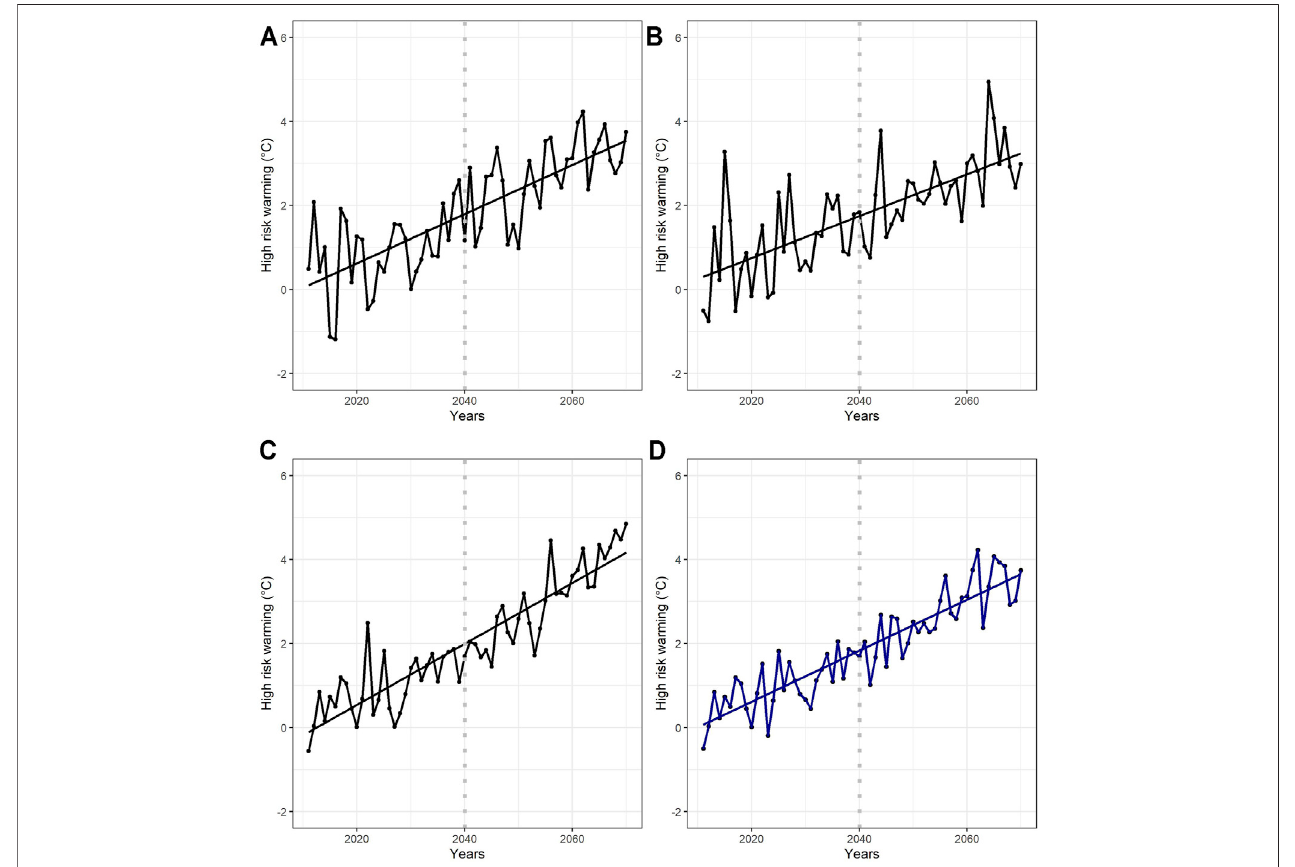
FIGURE 5 | HRW of temperature gauges in Ecuador from CSIRO (A) , GISS (B) , and IPSL (C) . Figure 5D is the ensemble that explains the median from three WGCMs. Values of the HRW axis are between − 2 ° C and 6 ° C.